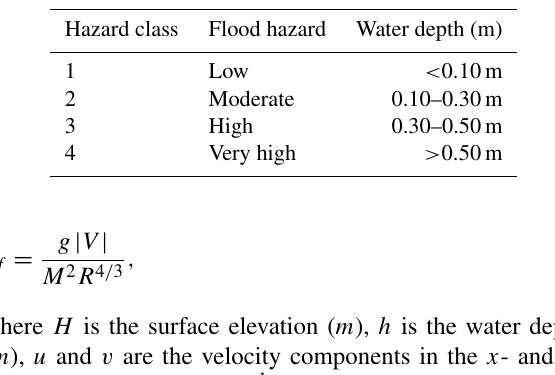
Table 2. Hazard classification used in this study based on water depths. Classification source is Krieger et al.